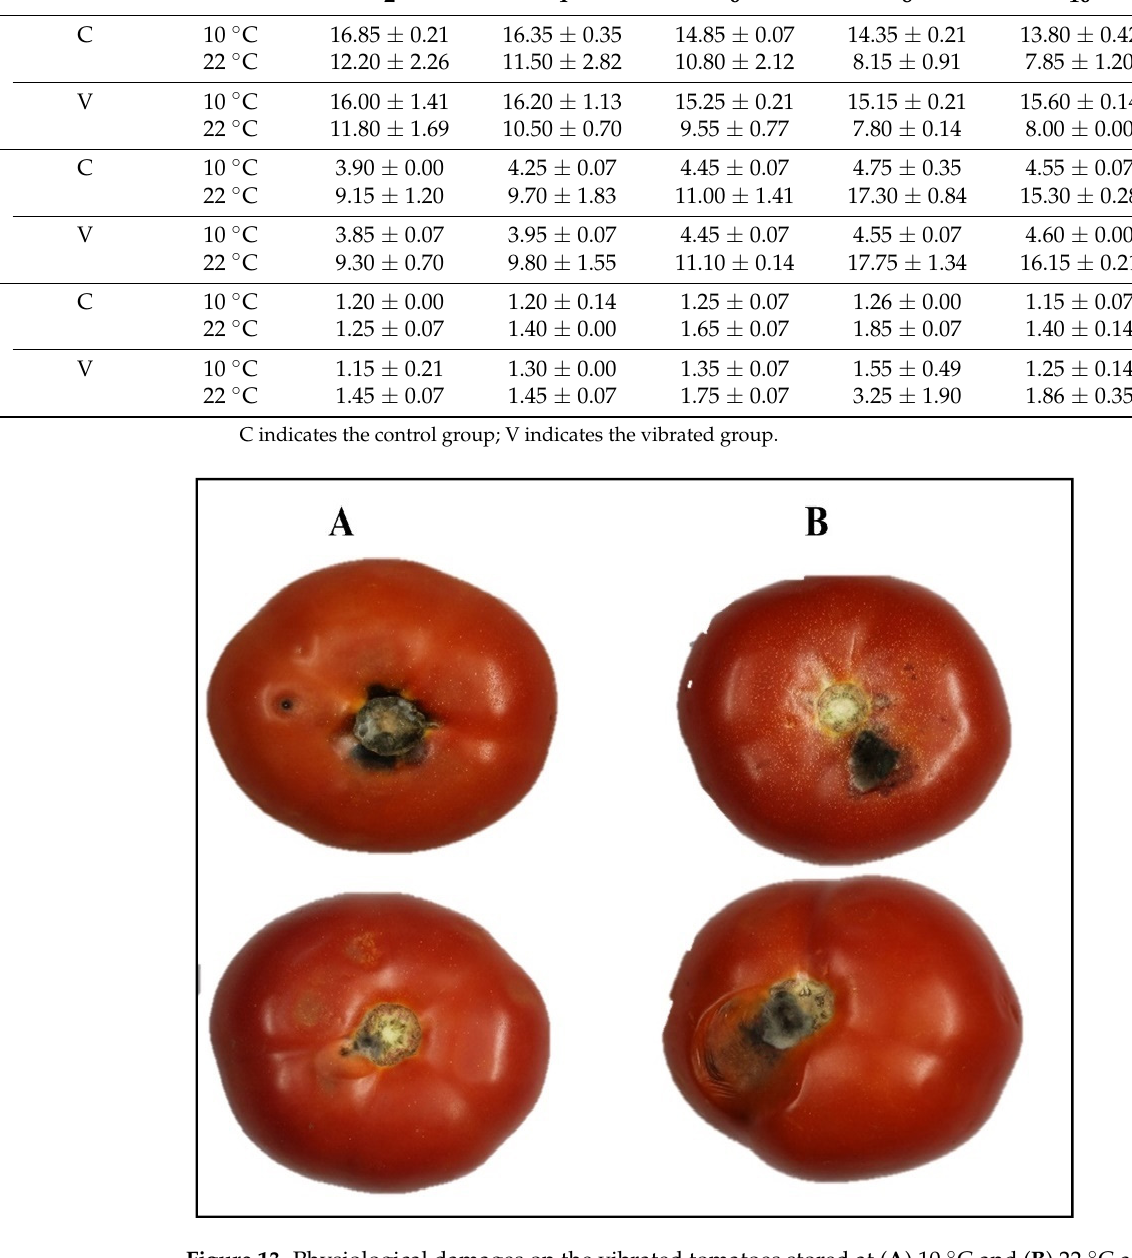
Table 3. O 2 %, CO 2 % concentration, and C 2 H 4 (ppm) production of control and vibrated tomato groups stored at 10 ◦ C and 22 ◦ C for 10 days storage period. Data are presented in mean values ± SD. Headspace